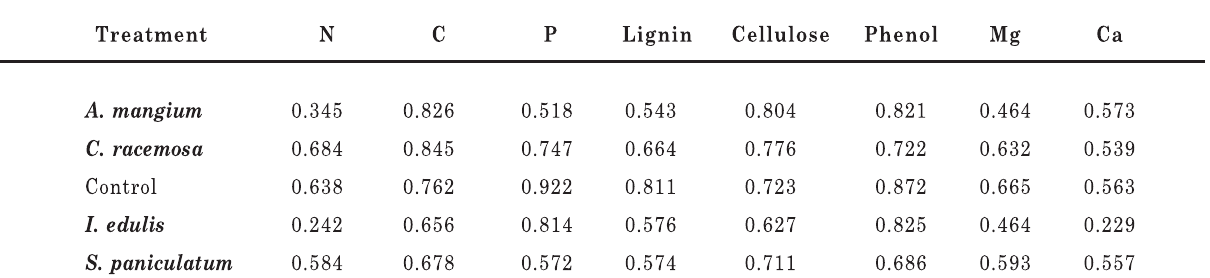
Table 4. Correlation coefficients from regressions of potassium concentration (g kg -1 ) and remaining dry matter (g) and some chemical properties (g kg -1 DM) during the incubation period. n =